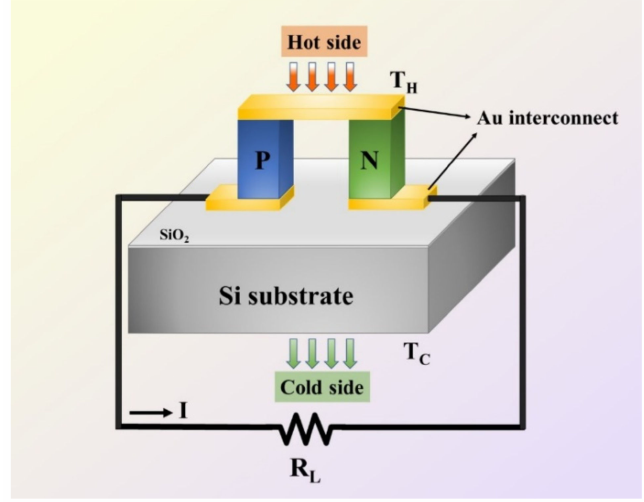
Figure 1. Schematic of single-leg pair